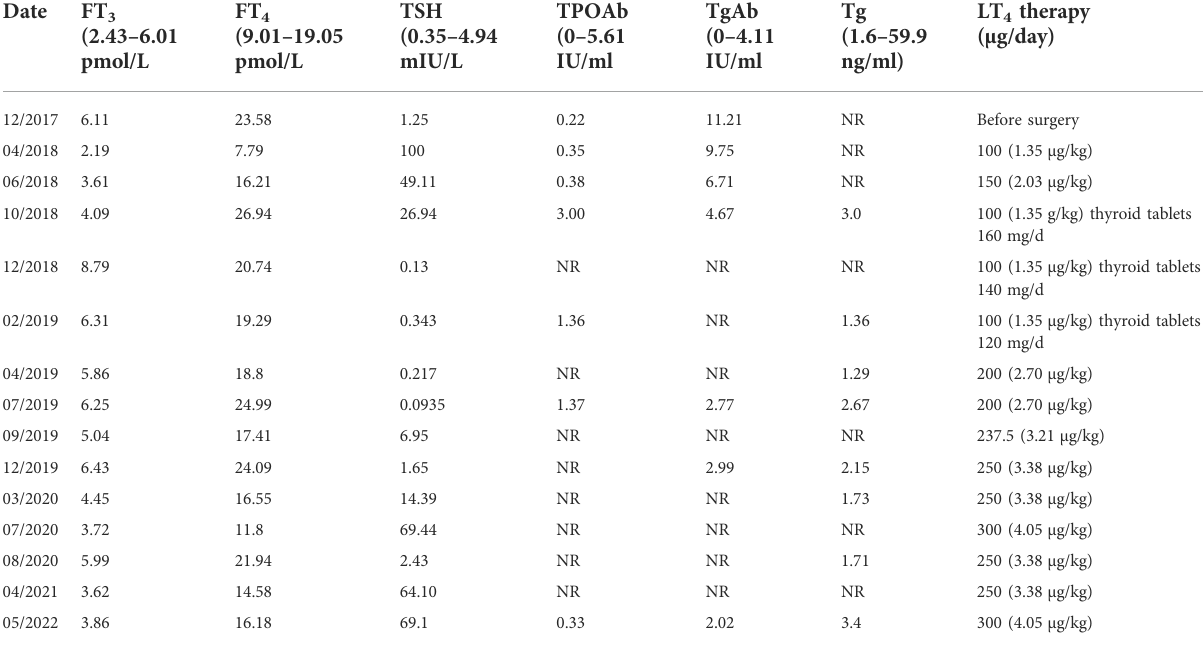
TABLE 2 Thyroid Indicators Measurement During Follow-Up of patient Two as Related to Levothyroxine